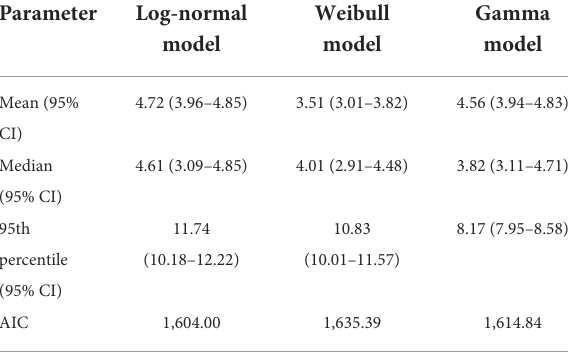
TABLE 2 Characteristics of patients with laboratory-confirmed COVID-19 included in this analysis ( N